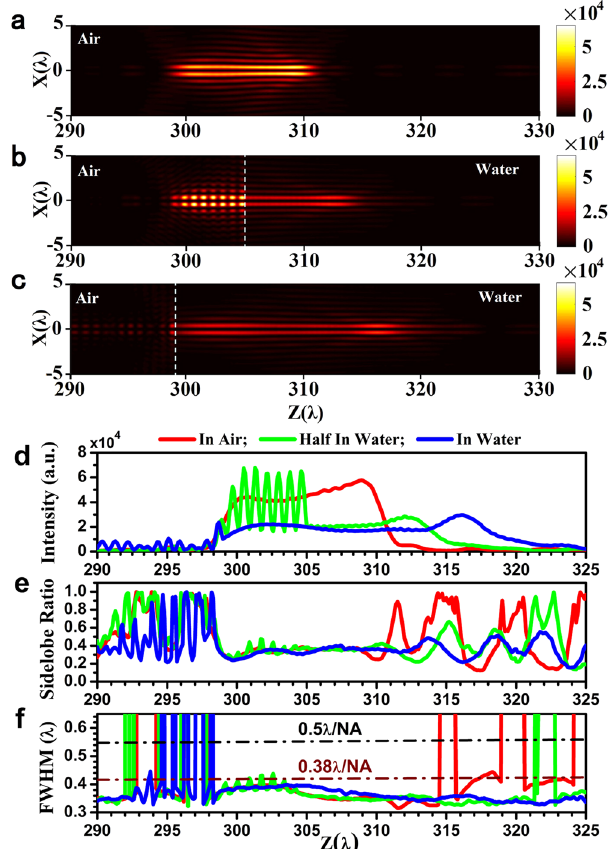
Figure 9. COMSOL numerical simulation results of optical hollow needle performance in air and water. Color maps of the optical hollow needle intensity in the propagation XZ plane ( a ) with the entire needle in air, ( b ) with half the needle in water, and ( c ) with the entire needle in water, where the dashed lines indicate the air- water interface at z = 305 λ for ( b ) and z = 299 λ for ( c ). The peak intensity ( d ), sidelobe ratio ( e ), and transverse FWHM ( f ) are plotted along the propagation direction for the three different cases of the entire needle in air (red), half the needle in water (green), and the entire needle in water (blue). The optical intensity, sidelobe ratio, and FWHM are given in arbitrary unit, ratio value, and λ respectively. And, the black and wine-colored dashed- dotted lines indicate the diffraction limit and super-oscillatory criterion,